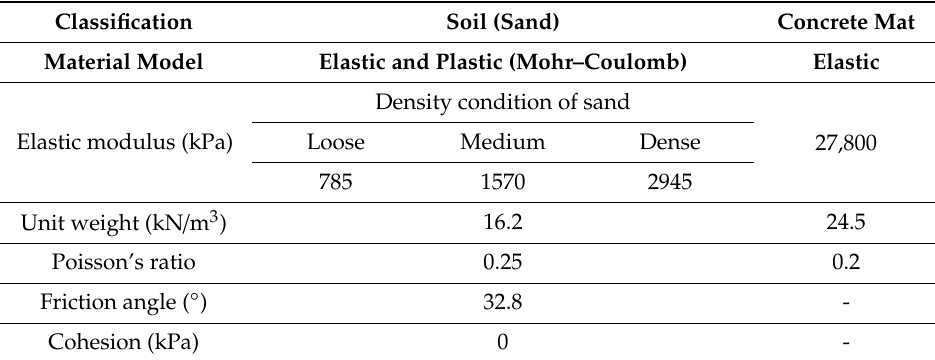
Table 3. Properties of the soil and concrete